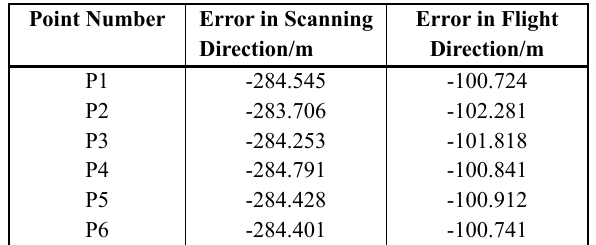
Table 4. Positioning Error of GCPs.